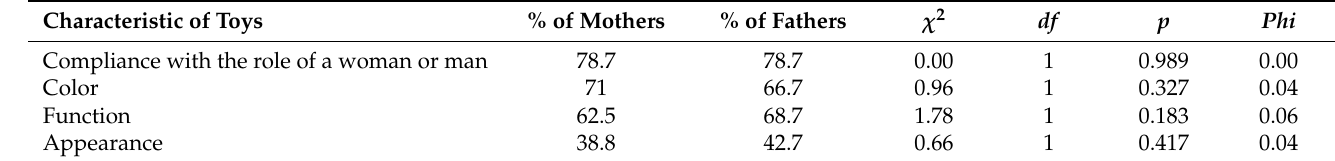
Table 4. Characteristics of toys affecting their categorization for girls or for boys—differences in parents’ opinions. Characteristic of Toys Compliance with the role of a woman or man